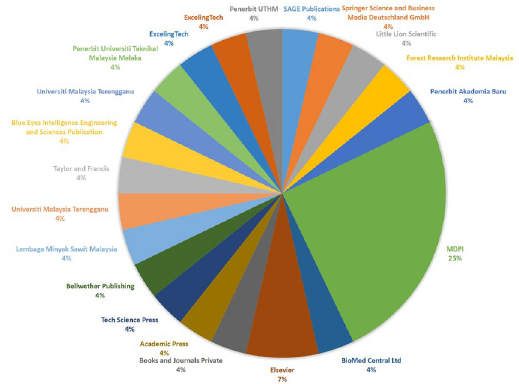
Figure 3. Contribution of the